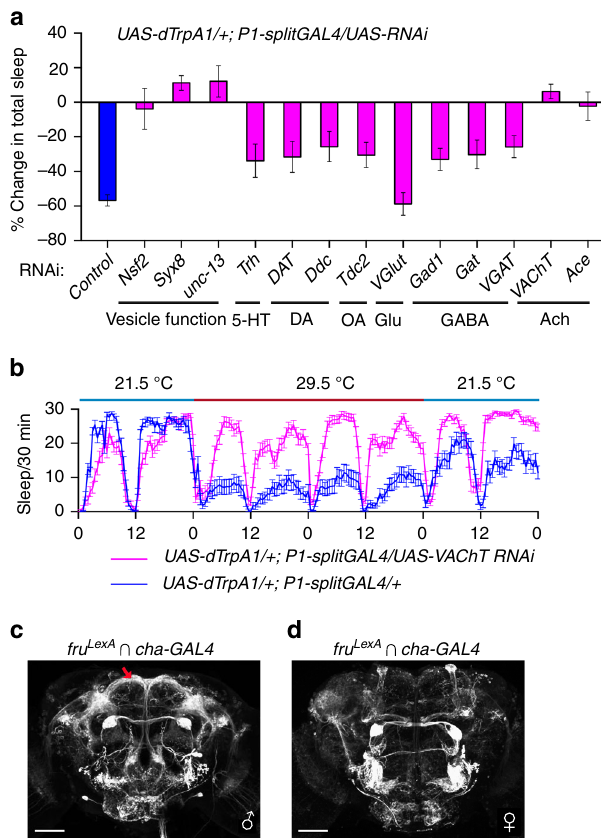
Fig. 4 ACh release by P1 neurons is required for sleep regulation. a Knocking down Ach in P1 neurons abolishes the effect of P1 activation on male sleep. The blue bar indicates P1 activation alone, while bars in magenta indicate P1 activation together with knocking down speci fi c genes in P1 neurons. n = 32 for each. b Detailed sleep pro fi les of P1 activation alone (in blue line ) and P1 activation together with VAChT knocked down (in magenta line ). c , d Intersectional expression of fru LexA and cha-GAL4 in a male brain c , where P1 neurons are labeled, and in a female brain d . Error bars indicate SEM. Scale bars, 50 µ